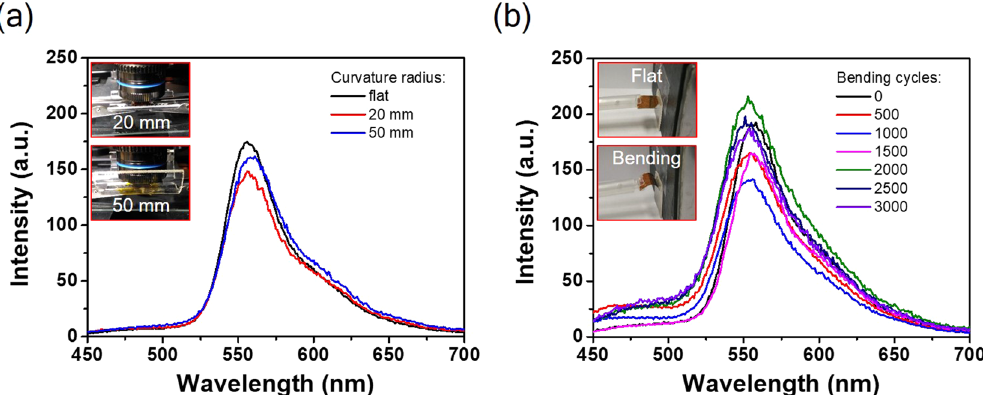
Figure 6. Bending performance of the transient HMMs on a flexible PET substrate. ( a ) Photoluminescence spectra of the R6G dye molecule on the HMM2 sample measured under different inner bending curvature radius. Insets are the curvature radius of 20 and 50 mm. ( b ) Photoluminescence spectra within 3000 bending cycles at a bending radius of ~5 mm. Insets are flat and bending behaviors of the transient HMMs